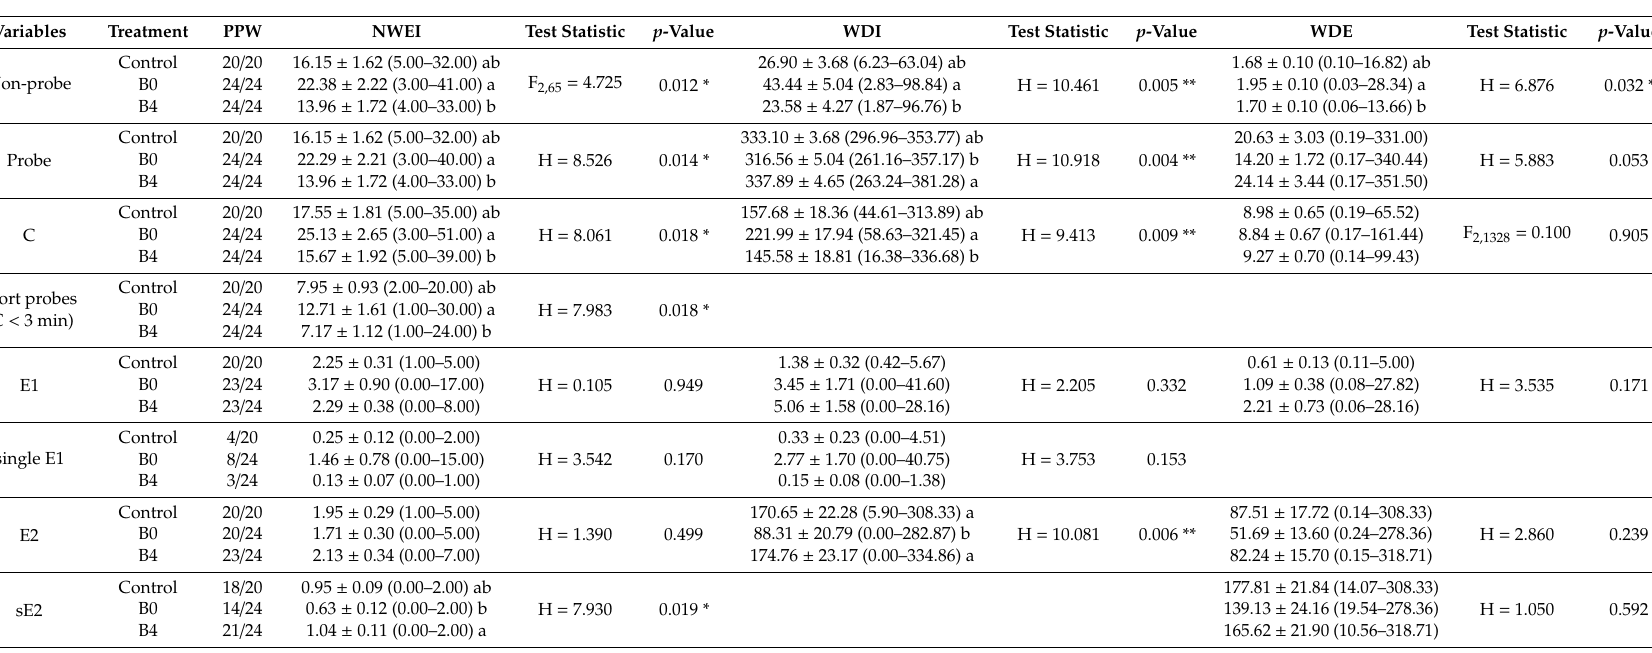
Table 2. Mean ± standard error (min) of non-sequential electrical penetration graph (EPG) variables and their ranges in parenthesis for the feeding behavior of Aphis gossypii exposed to melon plants at 0 (fresh residue) (B0) and 4 days (B4) after sprayed BTH (benzo-(1,2,3)-thiadiazole-7-carbothioic-acid S-methyl ester), using water-sprayed plants as control, during a six-hour